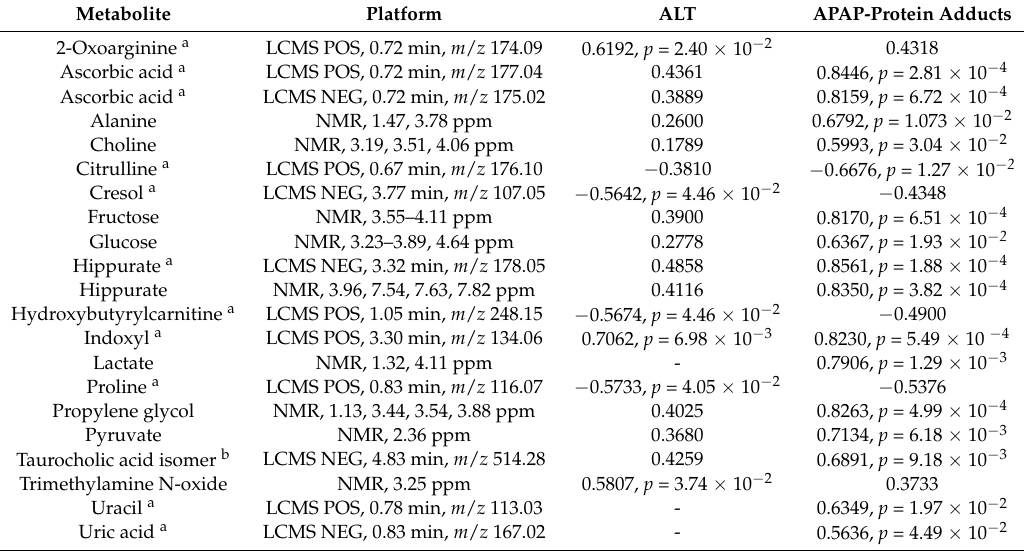
Table 2. Select metabolites with high correlations to alanine aminotransferase (ALT) or acetaminophen (APAP)-protein adducts. Metabolites with significant correlations ( p 0.05) to ALT or APAP-protein adducts are in